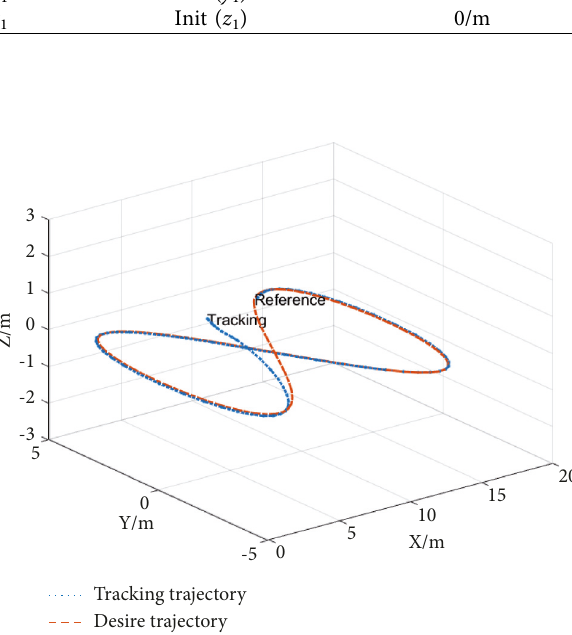
Figure 9: The result of tracking desire trajectory in